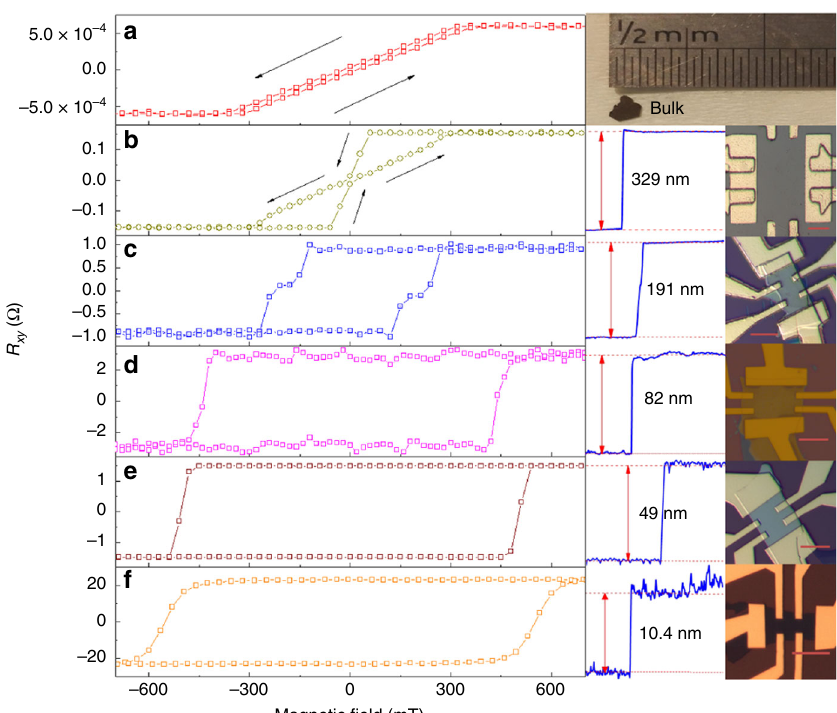
Fig. 1 R xy ( B ) for FGT nano fl akes of various thicknesses at 2 K. Each red scale bars represents 10 μ m. a Bulk device, L × W × T = 1.8 mm × 0.8 mm × 0.3 mm. M M = 0.0715. b A device with a thickness of 329 nm, L × W × T = 44.4 μ m × 49.4 μ m × 329 nm. M R / S nm, L × W × T = 14.7 µ m × 9.25 µ m × 191 nm. M R / M S = 0.9757. d A device with a thickness of 82 nm, L × W × T = 10.3 µ m × 19.5 µ m × 82 nm. M R / M S = 0.9839. e A device with a thickness of 49 nm, L × W × T = 12.6 µ m × 13.1 µ m × 49 nm. M R / M S = 0.9980. f A device with a thickness of 10.4 nm, L × W × T = 12.7 µ m × 8.79 µ m × 10.4 nm. M M = R / S